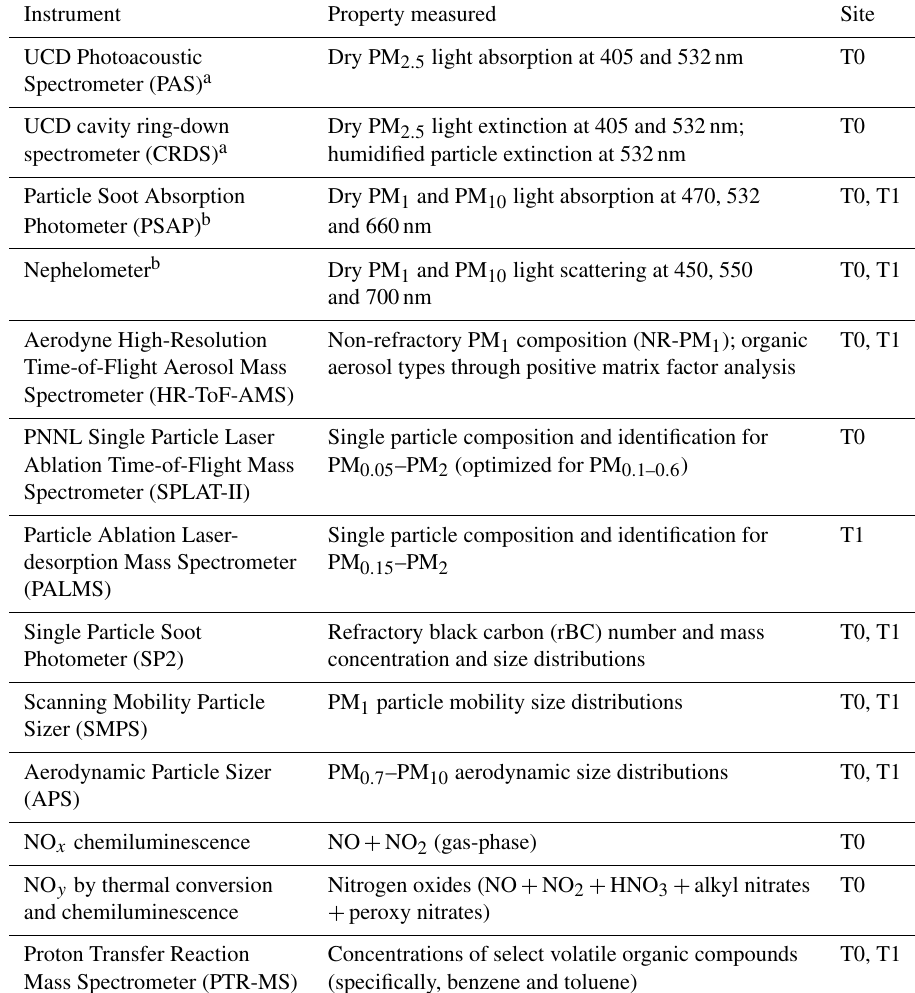
Table 1. Table of instrumentation.